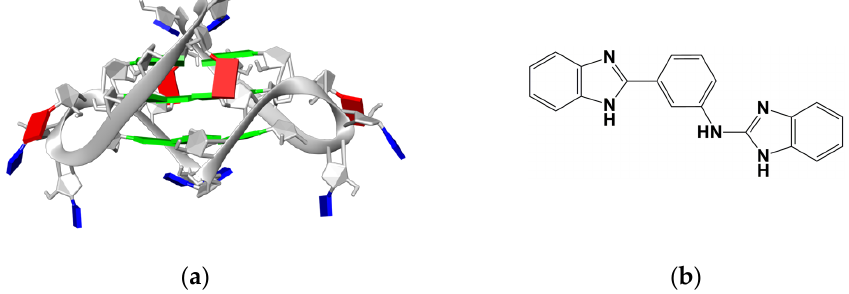
Figure 1. ( a ) Bimolecular G4 structure formed by TERRA RNA (guanine, green; adenine, red; uracil, blue). ( b ) Chemical structure of compound BPBA .